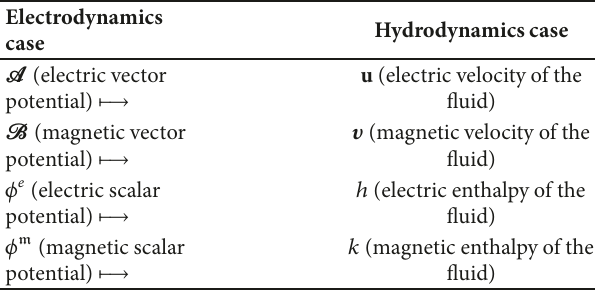
Table 1: Analogies between electrodynamics and hydrodynamics in presence of